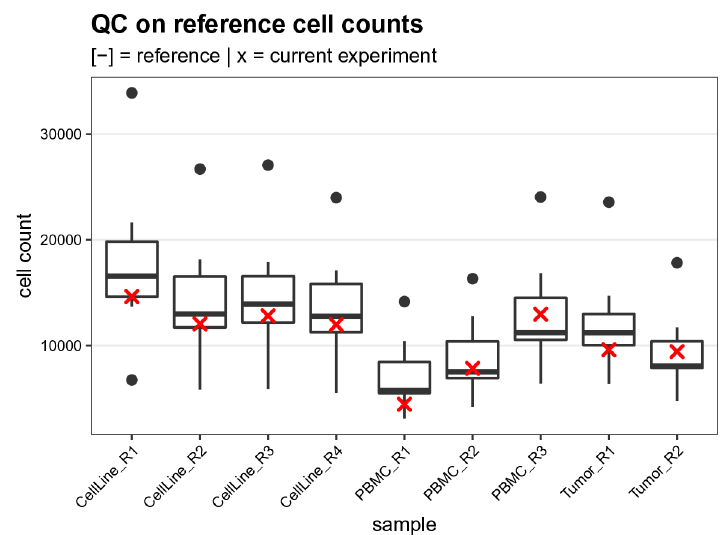
Figure 14. Reference cell count quality control. Boxplot comparing the reference cell counts obtained for the current experiment (red crosses) to those from 7 previously acquired